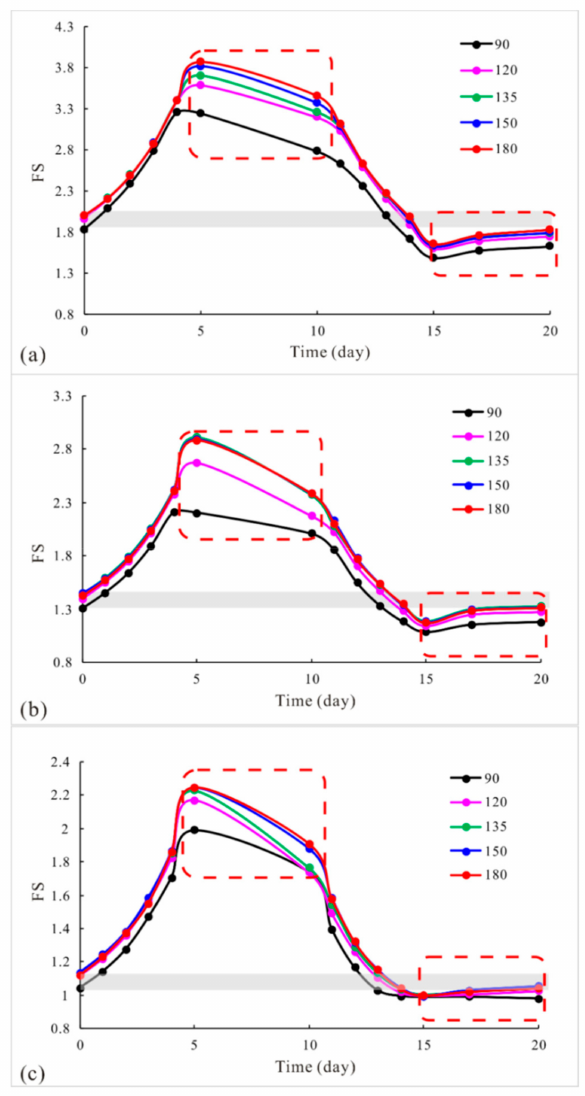
Figure 11. Variation of safety factor with water fluctuations: ( a ) gentle slope gradient of 1:2; ( b ) steep slope gradient of 1:1 and ( c ) very steep slope gradient of